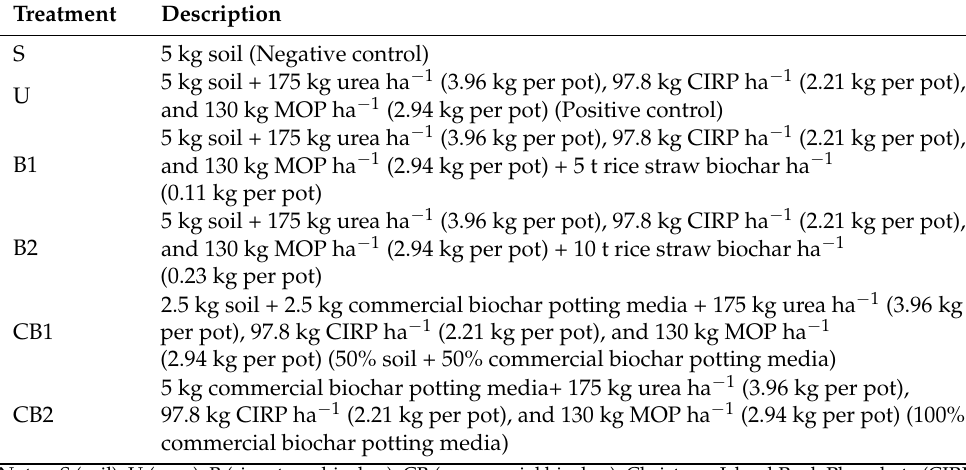
Table 4. Treatments evaluated in pot study.